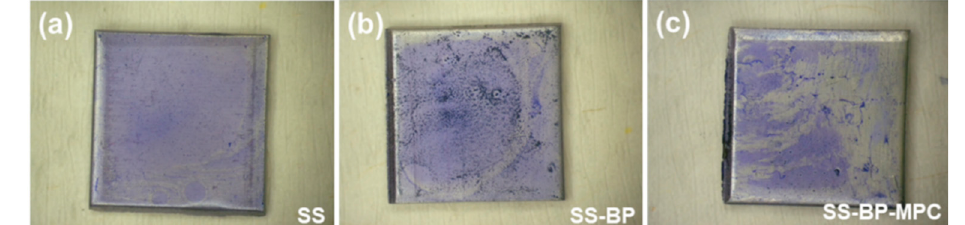
Figure 6. Photographs of ( a ) pristine SS, ( b ) SS-BP, and ( c ) SS-BP-MPC composites co-cultured with S. aureus bacteria for 12 h.